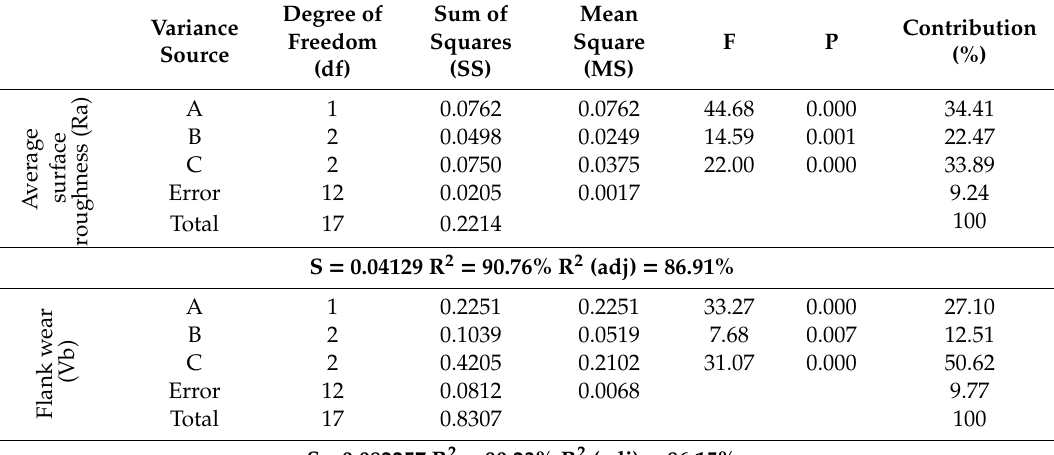
Table 8. ANOVA results for average surface roughness (Ra) and flank wear (Vb).